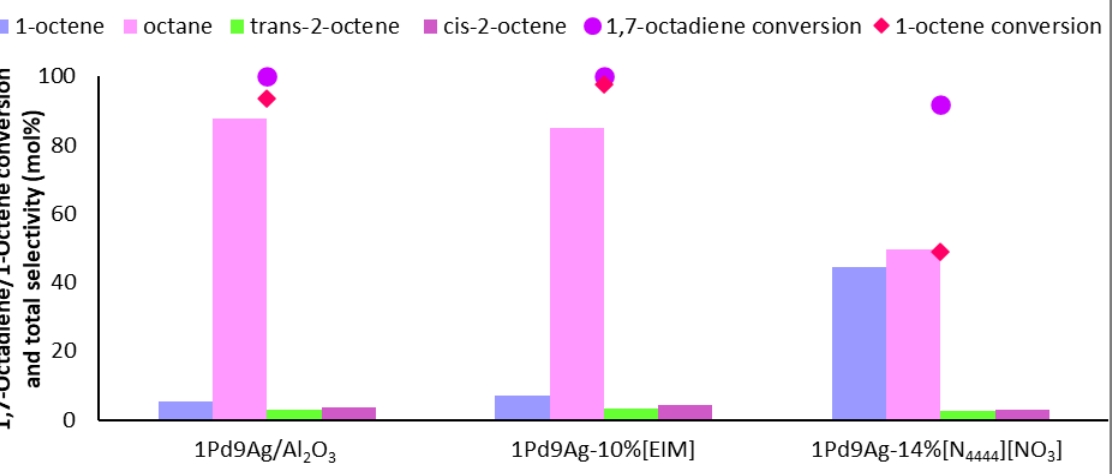
Figure 3. Selectivity profile of 1-octene, internal octenes, and octane over 1Pd9Ag-14%[N 4444 ][NO 3 ]. Reaction conditions: Temperature: 100 °C, Pressure: 30 bar, Diene:H 2 ratio: 1:3.5, LHSV: 9 h −1 , Feed: 2 wt% 1,7 octadiene, 10 wt% octene in hexane.